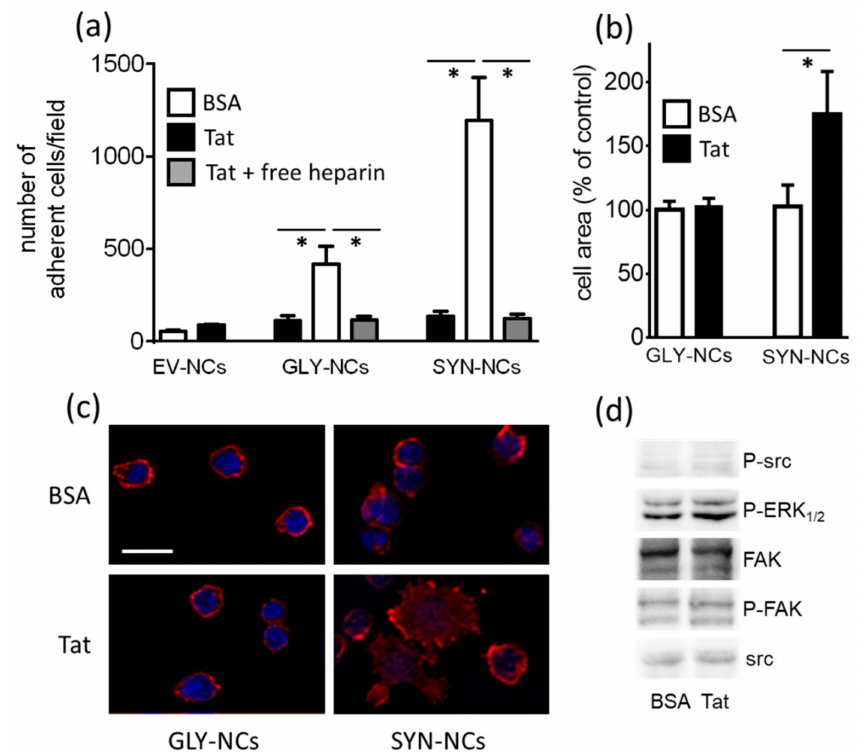
Figure 2. Comparison between GLY-NC and SYN-NC adhesion and spreading onto substrate- immobilized Tat. ( a ) GLY-NCs and SYN-NCs were seeded onto plastic-immobilized BSA or Tat in the absence or presence of free heparin (290 µ M). After 2 h, adherent cells were counted. Re- sults are expressed as mean ± S.E.M. of the number of adherent cells/well. * p < 0.01, one-way ANOVA. ( b ) The area of Tat-adherent GLY-NCs or SYN-NCs was measured and expressed as mean percentage ± S.E.M. in respect to the area of BSA-adherent cells. * p < 0.01, one-way ANOVA. ( c ) Representative microphotographs of GLY-NCs or SYN-NCs adherent to BSA or Tat immunos- tained for actin (red) and nuclei (blue) (scale bar 10 µ m). ( d ) Tat-adherent GLY-NCs were analyzed in WB for phosphorylated (P) src, ERK 1/2 and FAK. The intensity of each band was normalized with respect to the corresponding control protein. The statistical significance of Tat-dependent activation was then calculated and reported in Table